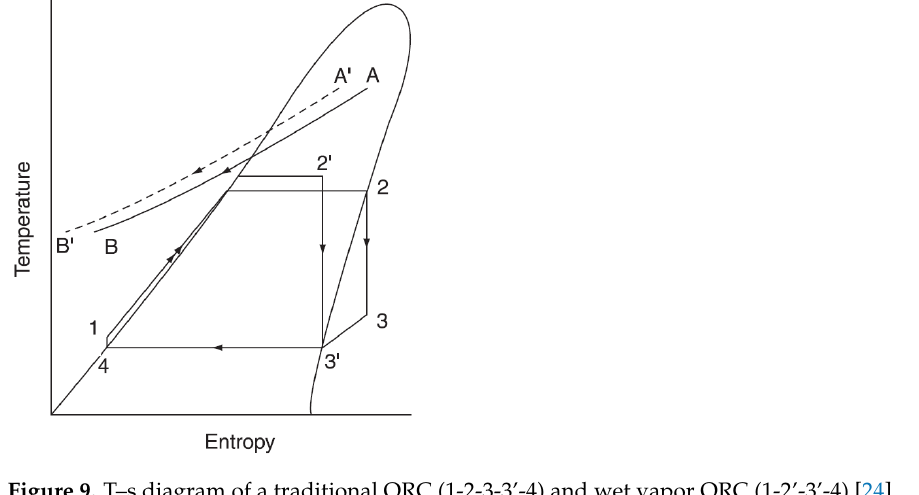
Figure 9. T – s diagram of a traditional ORC (1-2-3-3 ’ -4) and wet vapor ORC (1-2 ’ -3 ’ -4) [24]. Recently, the application of two-phase expanders and two-phase compressors was proposed in an innovative combined cooling, heating, and power (CCHP) thermodynamic cycle (Figure 10). It consists of the first subcircuit (1-2-2*-3-4-5-5*-6-7-8) and second subcircuit (1-9-10-11-12), where the first and second part of the working fluid mass flow rate circulate after partition in the split (point 1). The supply of electric power to the end-user takes place thanks the expansion processes (4–5, 5*–6, 7–8 and 9–10), whereas the supply to the end-user of heating power and cooling power occur through the condenser (6–7) and evaporator (10–11), respectively [27–29].